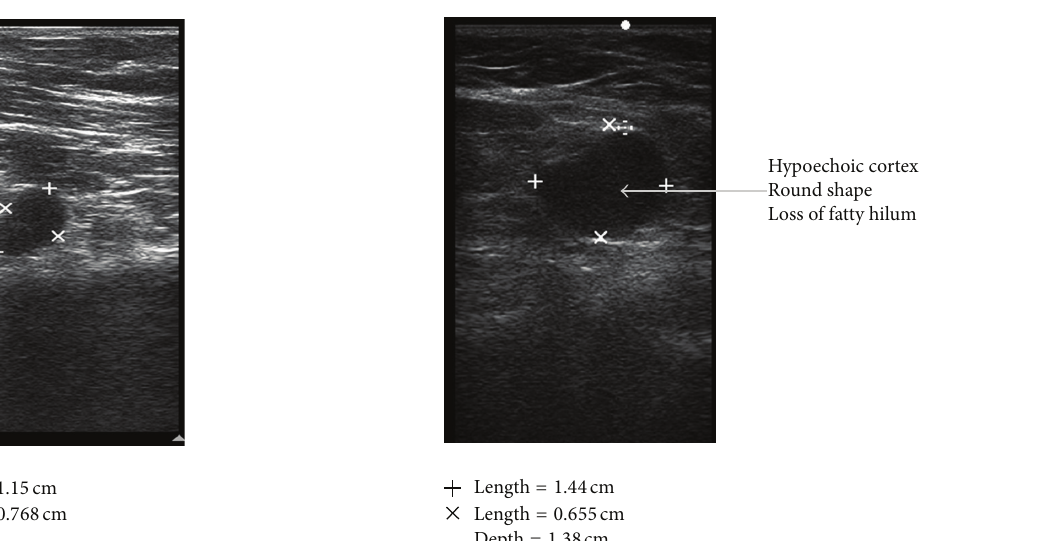
Figure 7: Involved lymph node: round shape, loss of fatty hilum, and hypoechoic internal